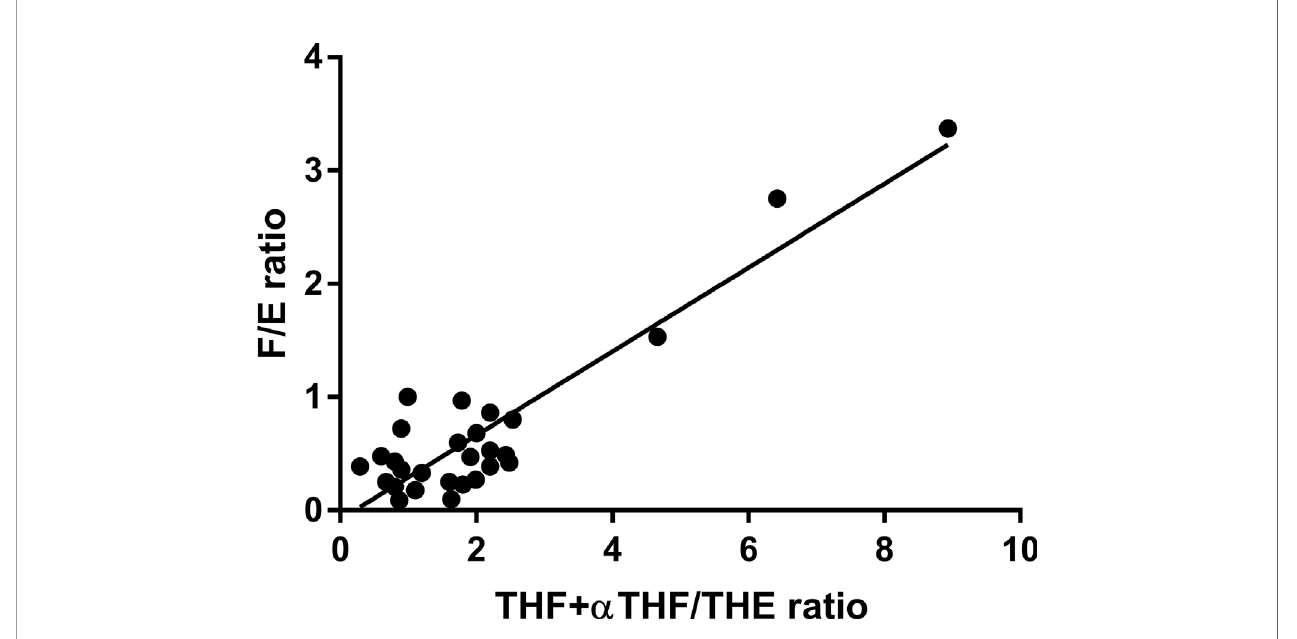
FIGURE 1 | THF+allo-THF/THE and F/E ratio correlation in the complete study population ( n = 28). r = 0.9134, p < 0.0001.